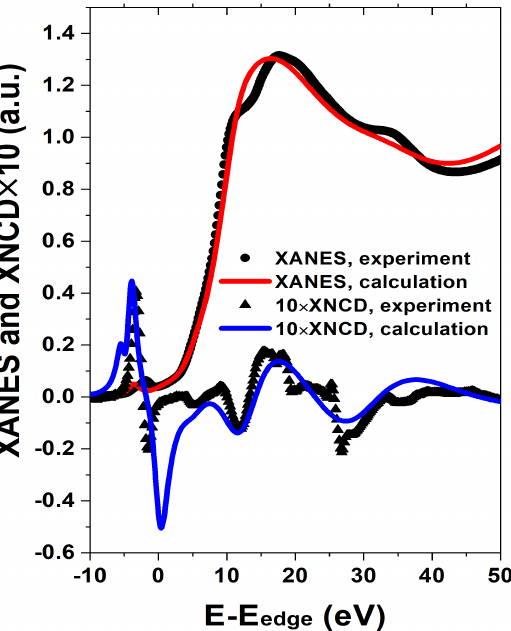
Figure 5. XANES and XNCD spectra at the Fe K -edge of the levo-enantiomer SmFe 3 (BO 3 ) 4 : calcula- tions versus experimental